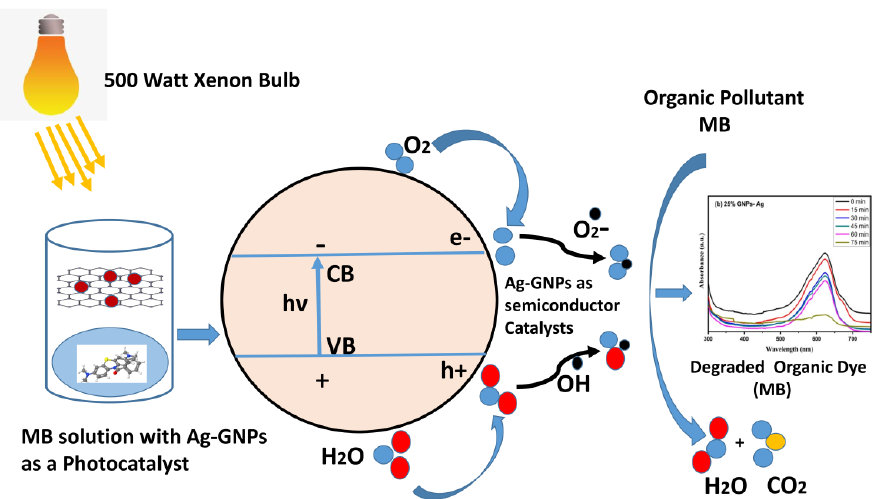
Figure 15. Schematic illustration of MB with (Ag) 1 − x (GNPs) x